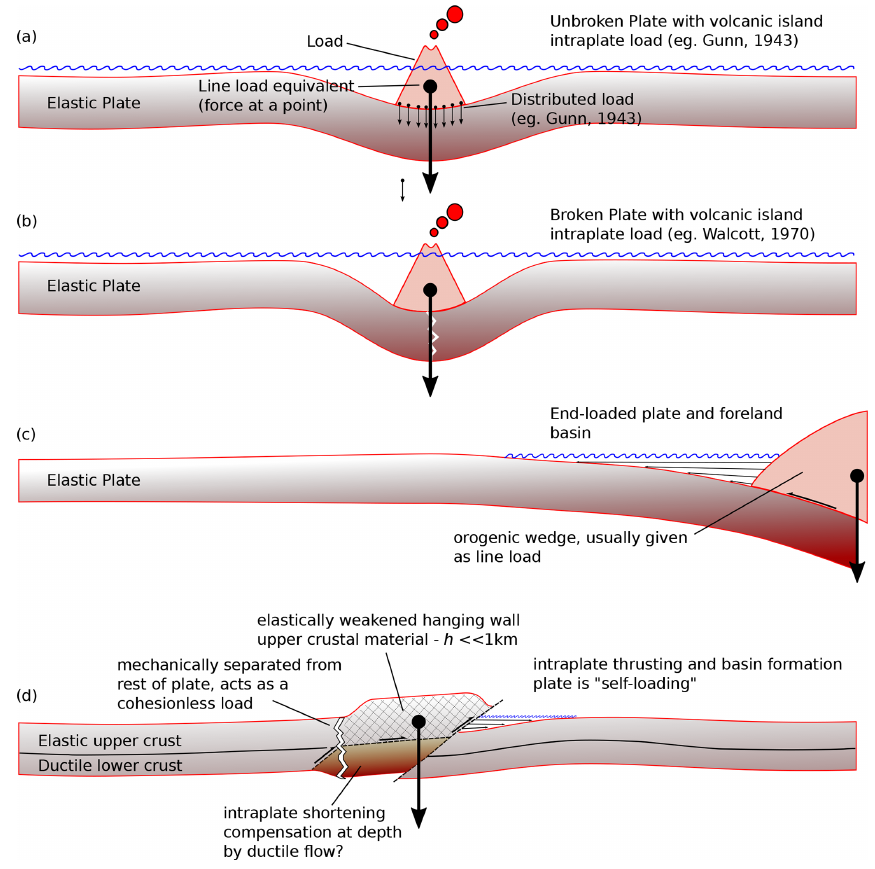
Figure 4. Traditional endmember models of flexural basins and details of a new intraplate flexural basin from this paper. (a) Mid-plate load on an unbroken plate after Gunn (1943a). (b) Mid-plate load on a broken plate after Gunn (1943a). (c) Edge load on the end of a plate typical of subduction zones after Gunn (1947). (d) Intraplate deformation-associated flexural basin from this paper with an assumed elastically weakened hanging wall and a basement thrust transecting most or all of the elastic crust and possible local weakening of the rest of the